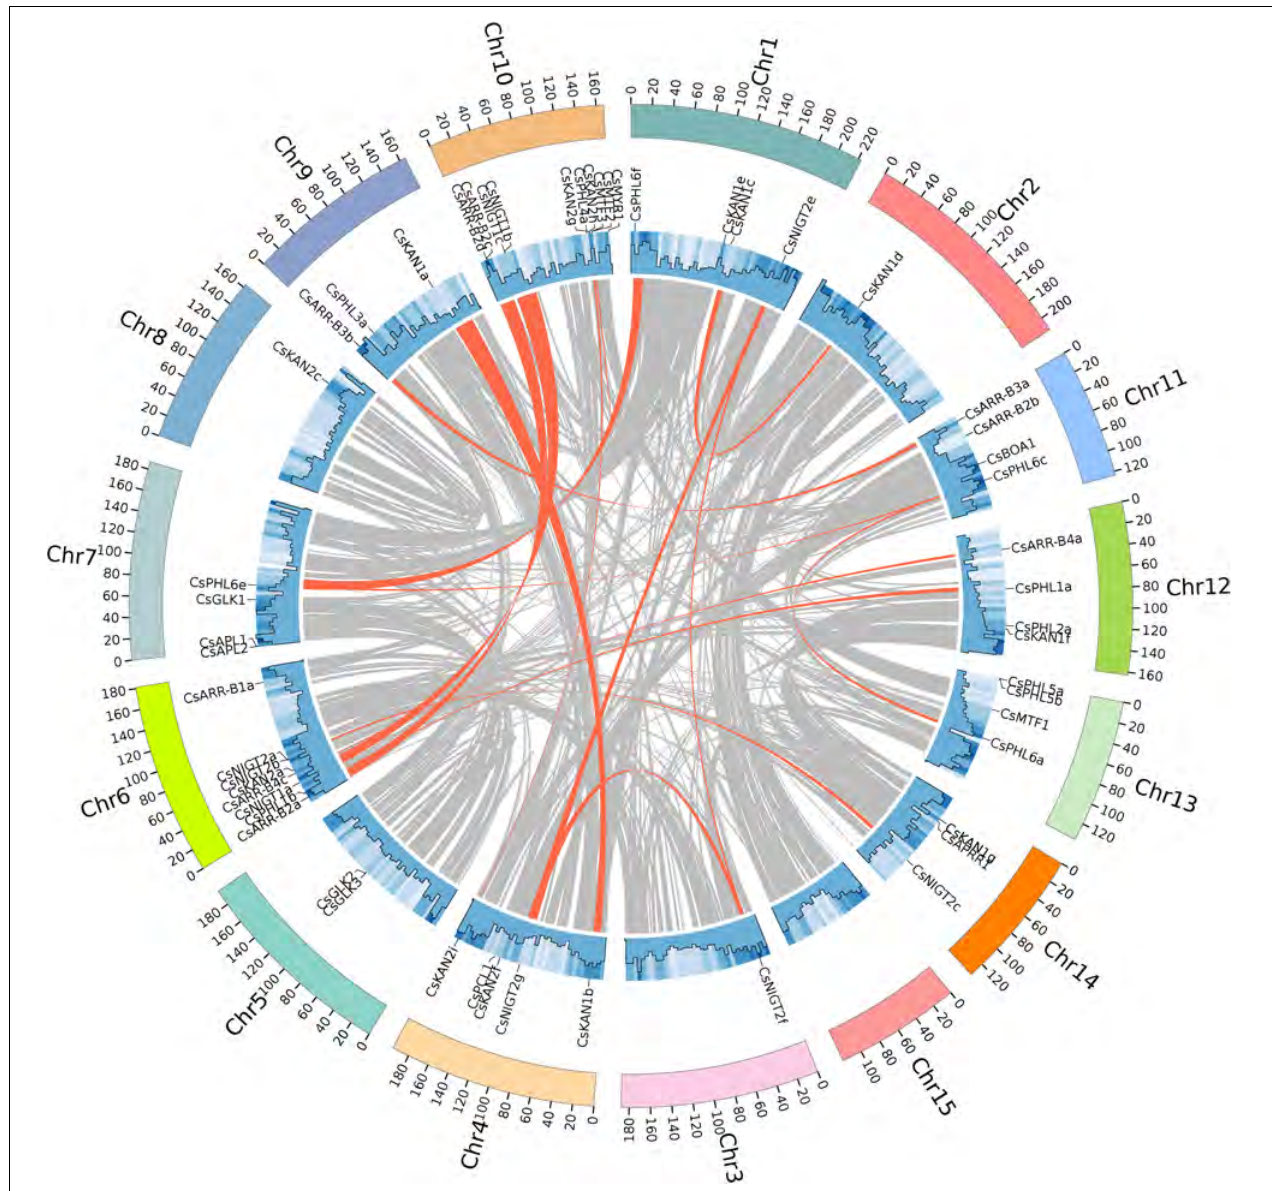
FIGURE 5 | Gene location, duplication, and collinearity analysis of CsGARPs . The gray curves show the details of collinear regions in the tea plant (Suchazao) genome, and the red curves show the gene pairs that have undergone segmental duplication.